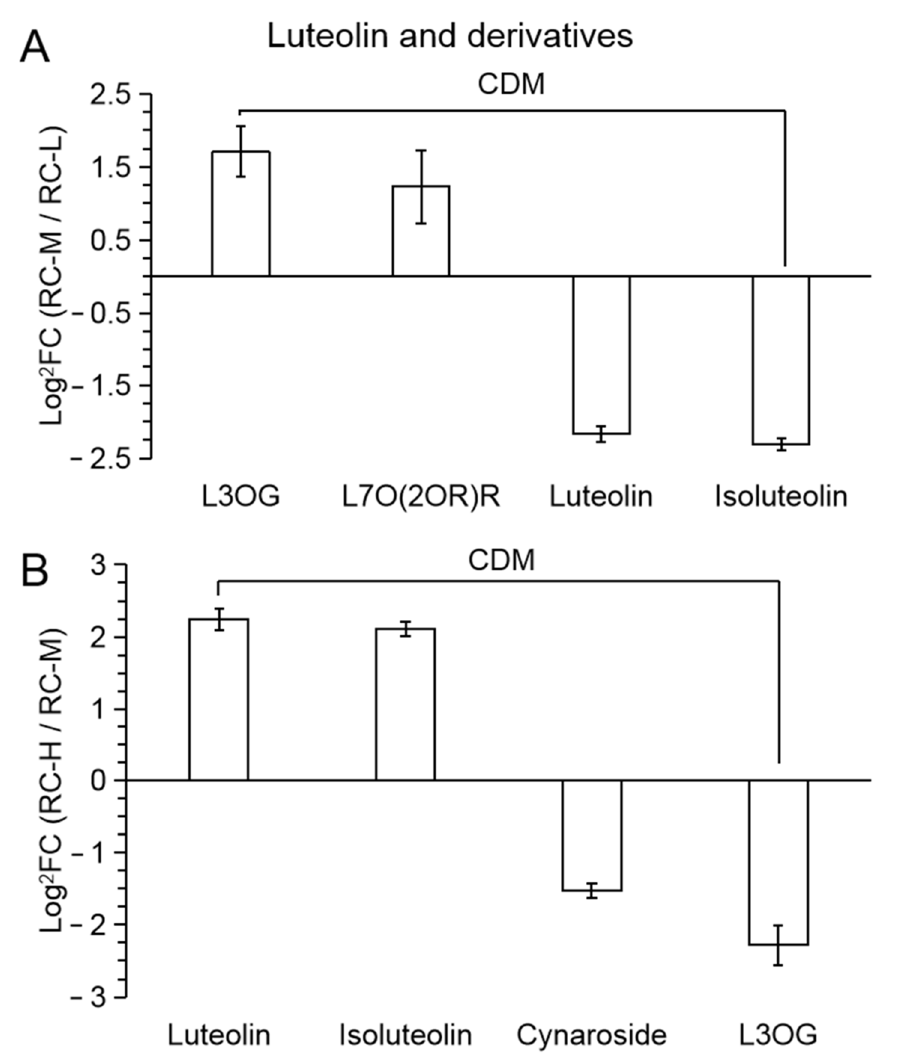
Figure 10. Comparison of differential metabolites of luteolin and its derivatives between RC-L, RC-M and RC-H. These were 0 CDMs for RC-H vs. RC-L, 4 CDMs for RC-M vs. RC-L ( A ), and 4 CDMs for RC-H vs. RC-M ( B ), respectively. Upregulation denotes that the content of a metabolite in RC increased with elevation between two altitudes, and the opposite for downregulation. The Y-axis is shown as Log 2 FC values for the convenience of visual presentation (Note: The up-amplitude in the text refers to the FC value). The X-axis denotes metabolite names.